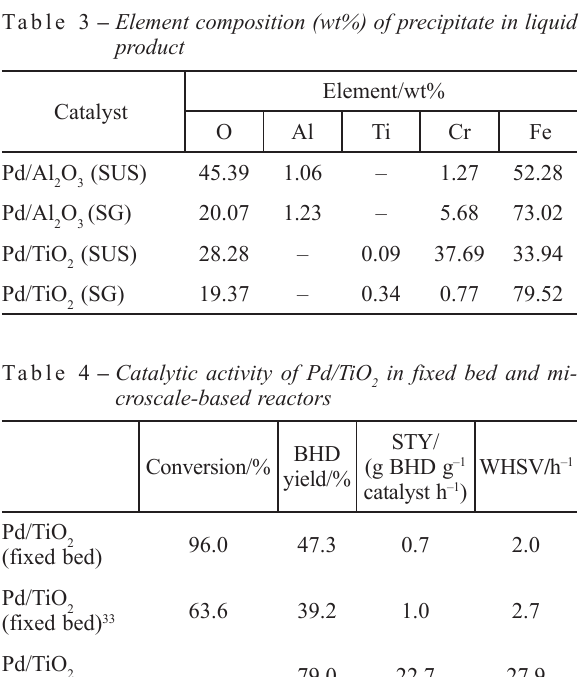
Table 3 – Element composition (wt%) of precipitate in liquid product Catalyst